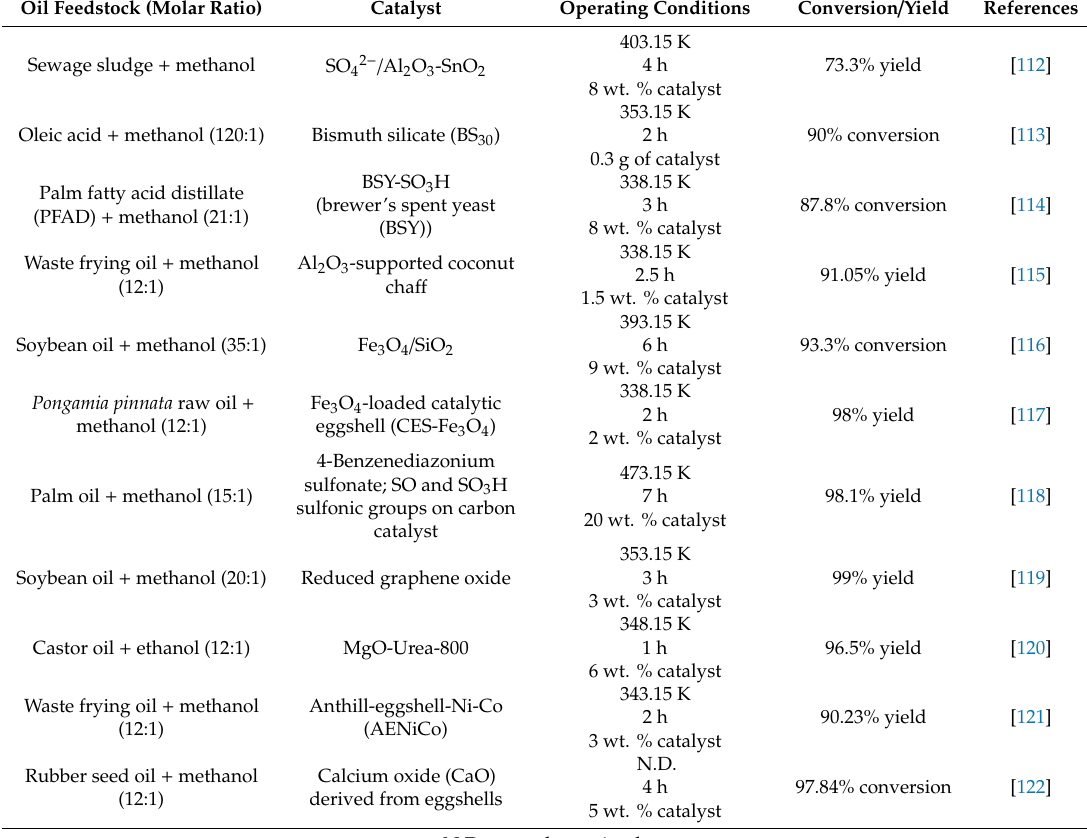
Table 1. Examples of the latest use of solid acid catalysts in biodiesel